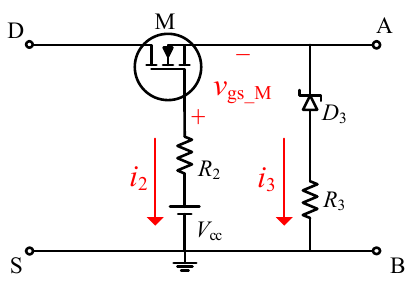
Figure 2. The schematic diagram of the improved DVCC.